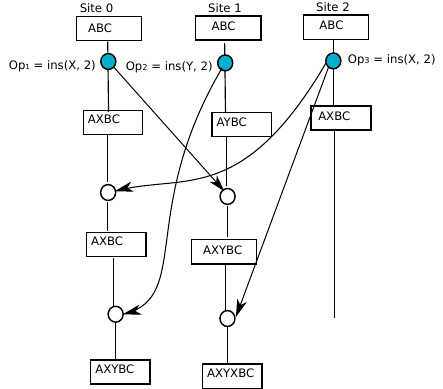
Figure 15. ACM divergence by using traditional